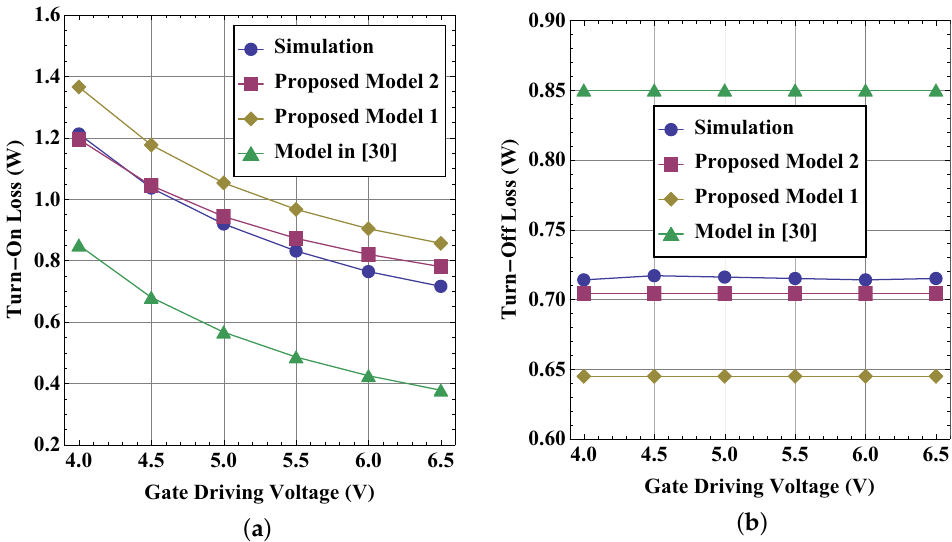
Figure 10. Switching loss of the models based on [30] at 10 MHz, 10 V input voltage, and 10 A load current: ( a ) turn-on loss as a function of gate driving voltage; ( b ) turn-off loss as a function of gate driving voltage. Table 6. The average relative error of different loss models based on two calculation methods when the gate driving voltage V dr changes from 4.0 V to 6.5 V at 10 MHz, 10 V input voltage, and 10 A load